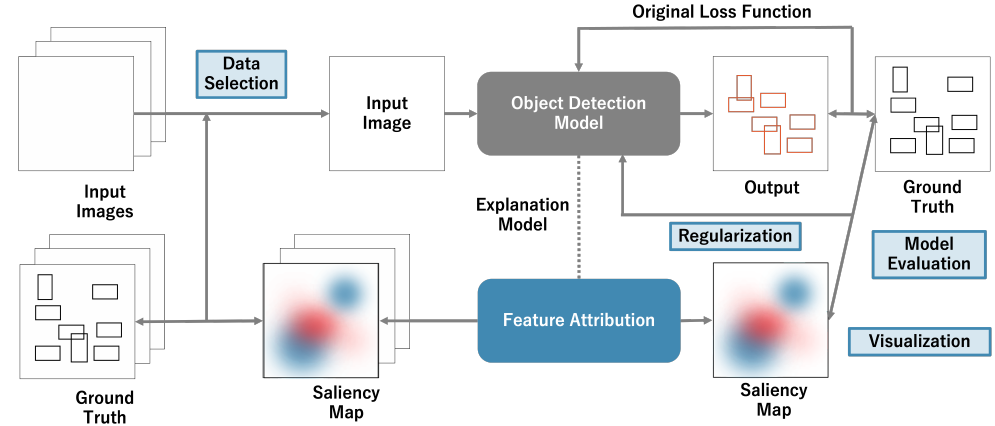
Figure 1. Overview of the proposed methods for visualizing the basis of inference, model evaluation, regularization, and data selection based on pixel-wise